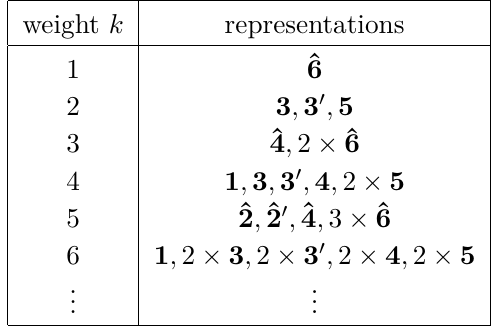
Table 11. Irreducible decomposition of M k (Γ(5)) . M k (Γ(5)) is a 5 k + 1 dimensional linear